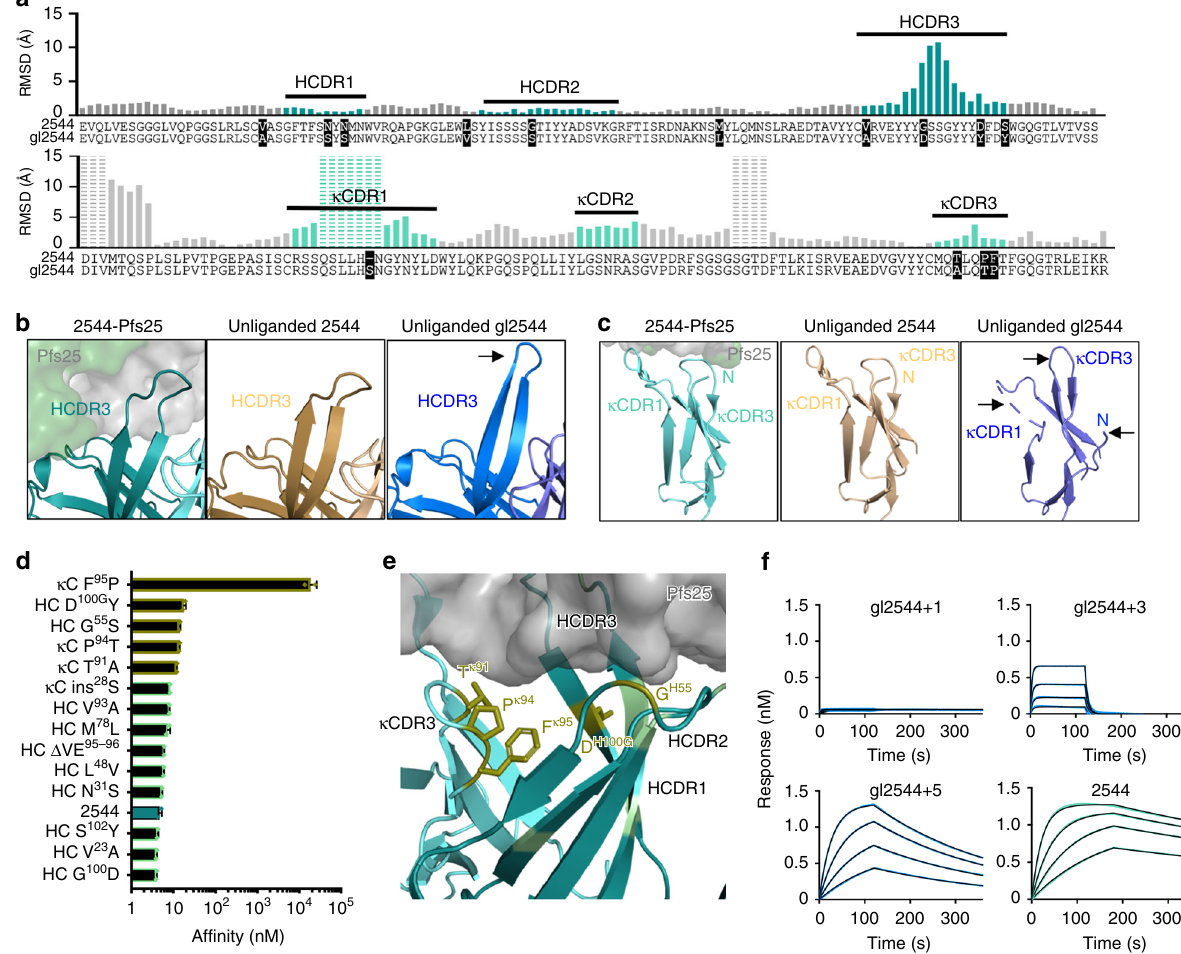
Fig. 5 Somatic hypermutations are required for 2544 high-af fi nity binding. a Alignment and RMSD plot between the variable regions of the heavy chains (top) and light chains (bottom) of Pfs25-bound 2544 and unliganded gl2544. Somatic hypermutations from germline are highlighted in black. Gray bars of RMSD plot refer to framework regions, while heavy chain and light chain CDRs are denoted by dark and light teal bars, respectively. Dashed bars refer to residues that do not display density in at least one of the crystal structures. b Comparison of the HCDR3 of Pfs25-bound 2544 (teal, left), unliganded 2544 (beige, middle), and unliganded gl2544 (blue, right). Arrow indicates region of notable structural shift. c Comparison of the κ CDR1 and κ CDR3 of Pfs25- bound 2544 (teal, left), unliganded 2544 (beige, middle), and unliganded gl2544 (blue, right). Arrows indicate regions of notable structural shift. d Af fi nities of 2544 germline-reversion mutations measured by BLI (immobilized Pfs25 and mutant Fab analyte). The fi ve reversions with the biggest impact on 2544 af fi nity are colored gold. Additional reversions are colored in pale green, and 2544 is colored in teal for comparison. Af fi nity is plotted as the mean of the measurements shown by solid diamonds, and the error is the standard deviation of the two kinetic measurements. e Position of the somatic hypermutations labeled in the 2544-Pfs25 crystal structure according to the scheme in d . Pfs25 is displayed in partial surface (gray), and 2544 is in teal. The fi ve residues identi fi ed as most critical for binding are shown in gold sticks. f Representative kinetic curves for Fabs binding to Pfs25 as measured by BLI (immobilized Pfs25 and Fabs as analyte). The top left is gl2544 with the P 95 F mutation in the κ chain (gl2544 + 1), the top right is gl2544 with A 91 T, T 94 P, and P 95 F mutations in the κ chain (gl2544 + 3), the bottom left is gl2544 with A 91 T, T 94 P, and P 95 F mutations in the κ chain, and S 55 G and Y 100G D in the heavy chain (gl2544 + 5), and the bottom right is 2544. A maximal Fab concentration of 1.5 µ M and a minimum of 187.5 nM for the gl2544 + 1 and gl2544 + 3 mutants, and a concentration range of 500 – 62.5 nM for gl2544 + 5 and 2544 were used for kinetic determination